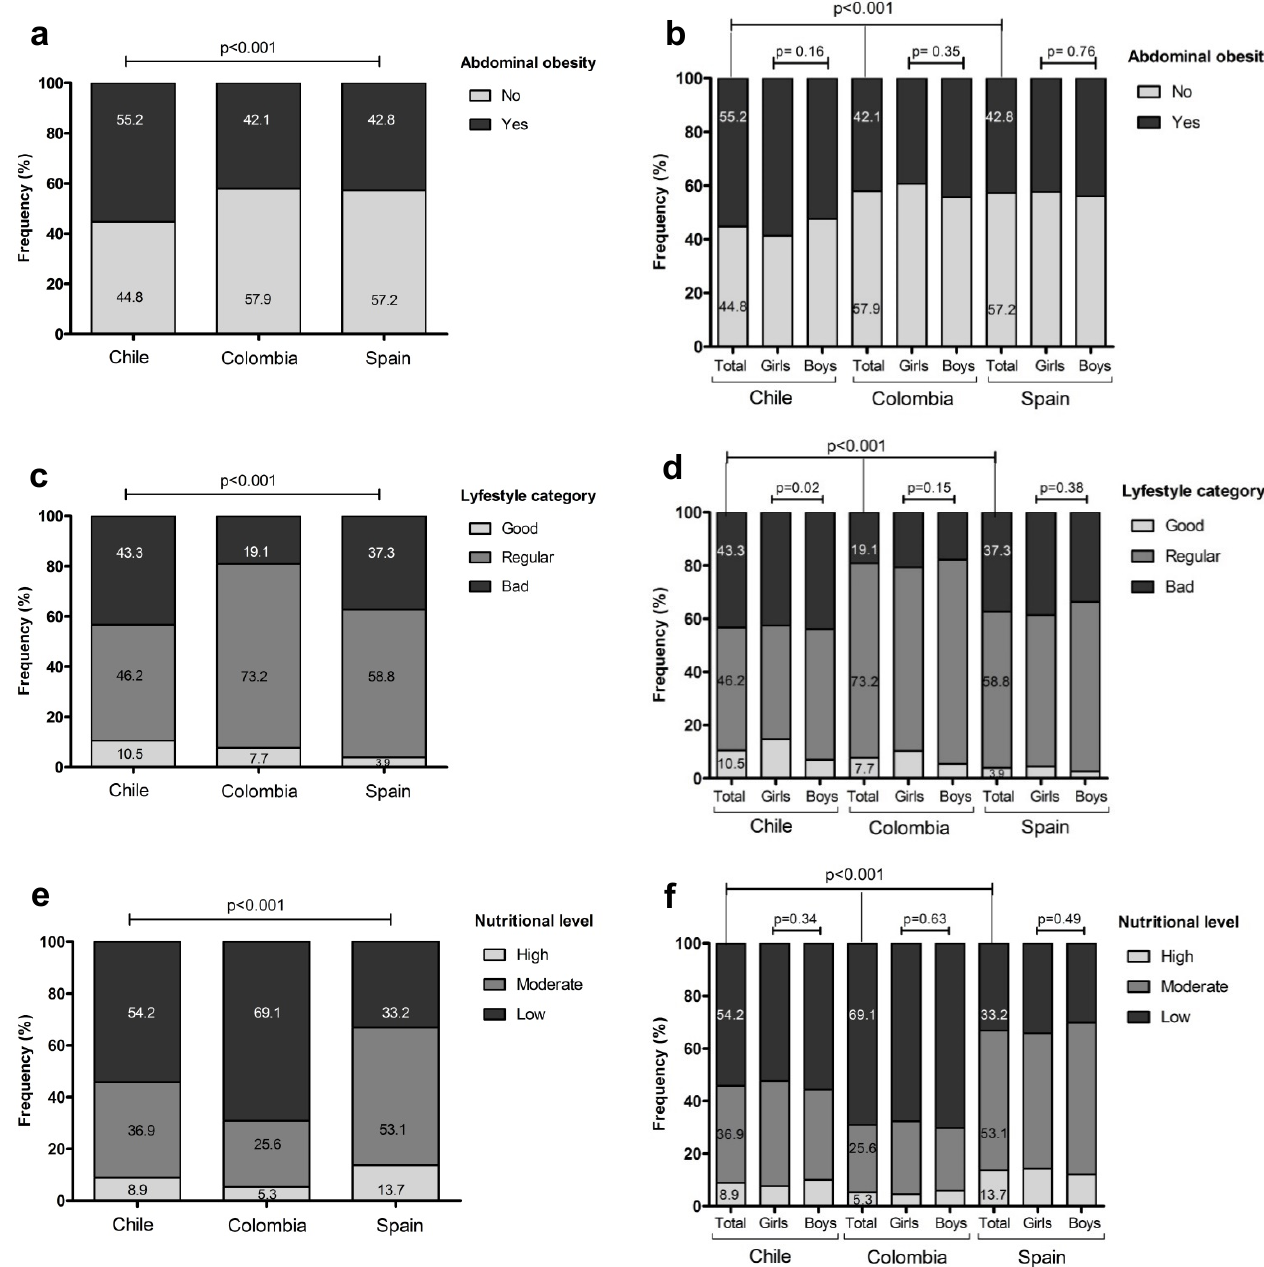
Figure 2. Frequency of abdominal obesity by country and sex (Panel a and b ), lifestyle category (Panel c and d ), and nutritional level (Panel e and f ) in children according to country and sex, for Chile, Colombia, and Spain.